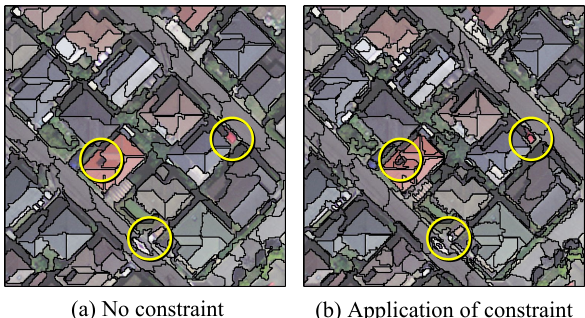
Figure 3. Effectiveness of constraint on spectral evaluation Fig. 4 indicates the comparisons on extension for smoothness criterion by modifying the definition used for extent of objects